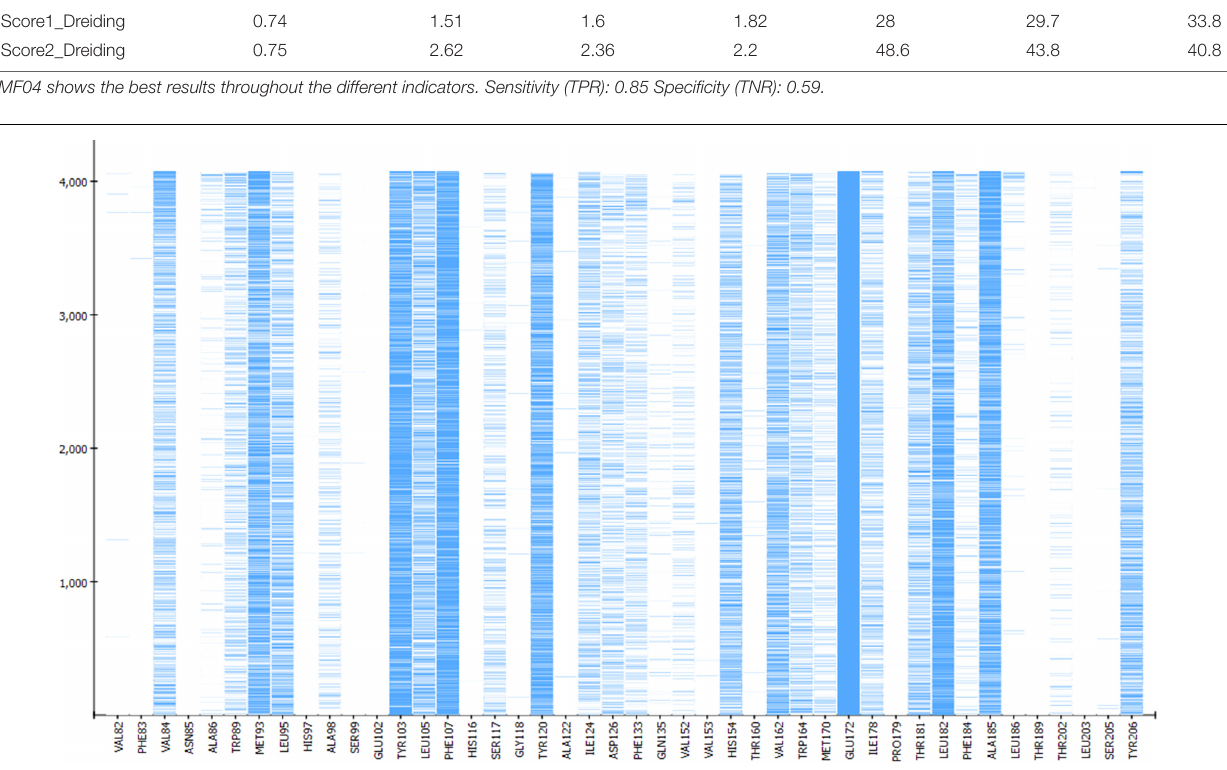
to capture diversity, we calculated all pairwise